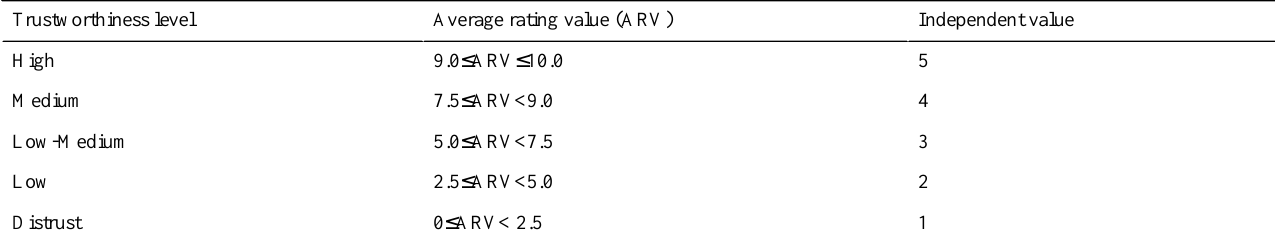
Table 2. Trustworthiness level